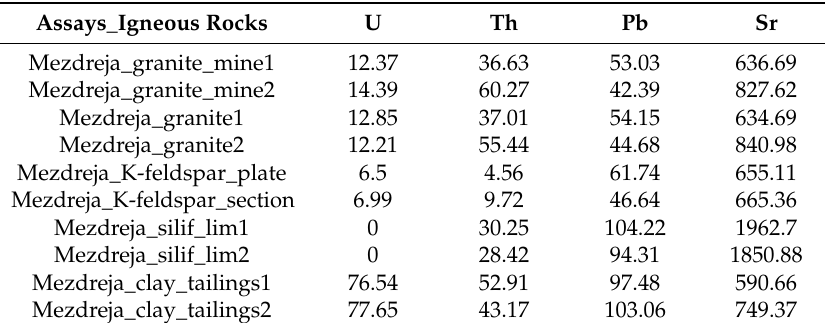
Table 2. Assays from the Mezdreja mine area (values are in